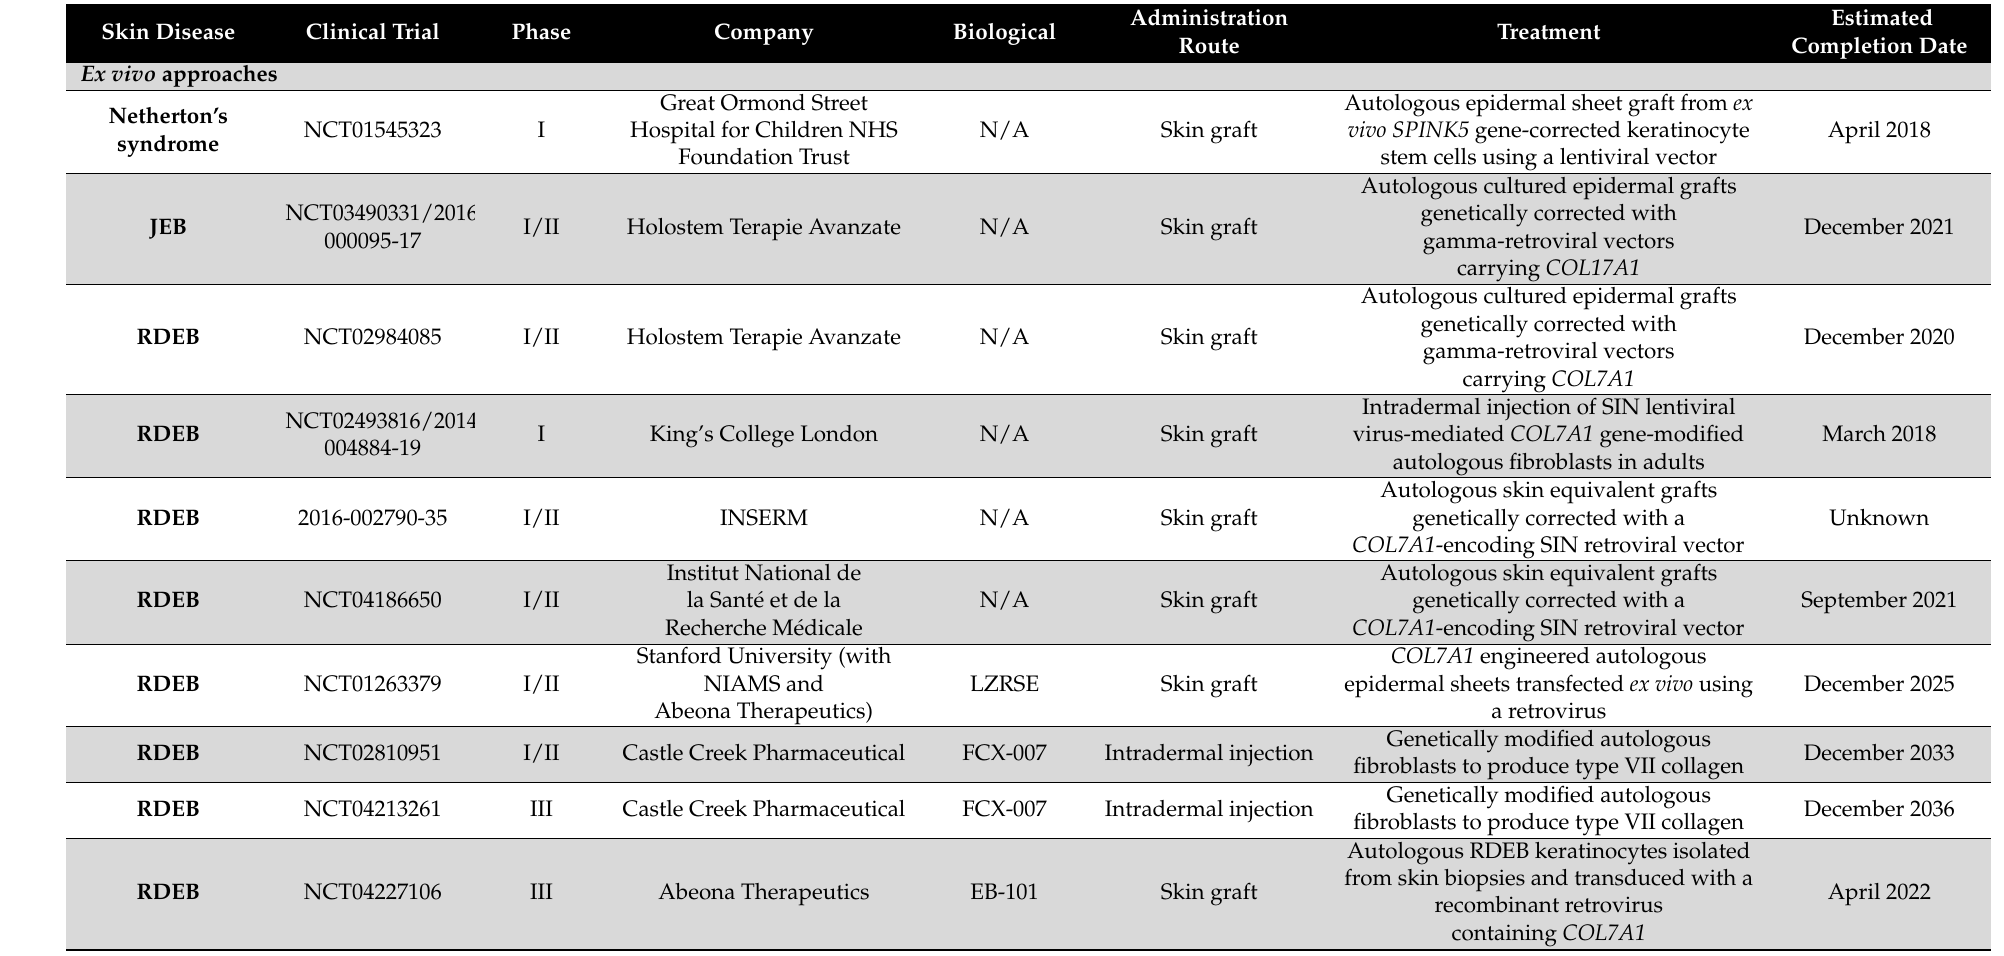
Table 1. Ongoing and completed clinical trials using gene therapy to treat dermatological conditions